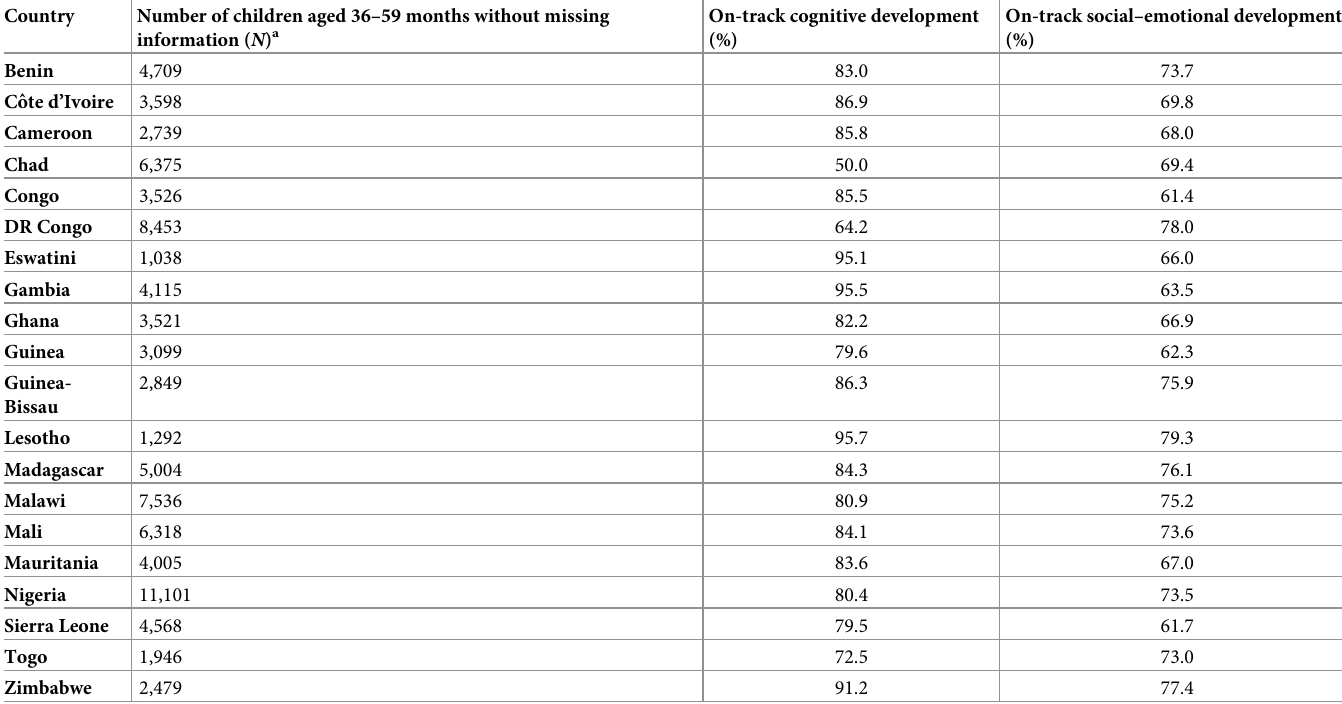
Table 4. Status of ECD of study participants. Country Number of children aged 36–59 months without missing information ( N ) a